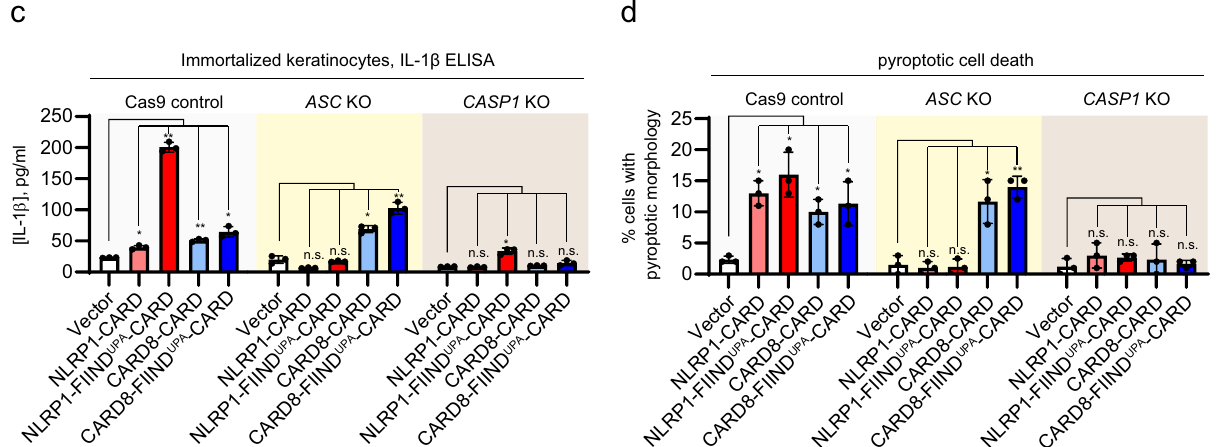
Fig. 6 NLRP1 and CARD8 in fl ammasome assembly in mammalian cells. a Structured illumination microscopy images of NLRP1-CARD-mCherry and CARD8-CARD-mCherry fi laments (red) with ASC-CARD-GFP and CASP1-CARD-GFP fi laments (green). White boxes indicate regions magni fi ed in right panels. b Percentage of ASC-GFP specks or CASP1-CARD-GFP fi laments induced by full-length NLRP1 or CARD8 upon Talabostat treatment (3 μ M). Data are presented as mean values ± SD. P value was calculated with one-way ANOVA, n = 3 treatments. ‘ */**/**** ’ indicates P value <0.05, 0.01, and 0.0001, correspondingly. c IL-1 β secretion in control, ASC KO, and CASP1 KO keratinocytes transfected with the indicated NLRP1 and CARD8 constructs. Data are presented as mean values ± SD. P value was calculated with one-way ANOVA, n = 3 transfections. ‘ */**/**** ’ indicates P value <0.05, 0.01, and 0.0001, correspondingly. d The percentage of cells with pyroptotic morphology in control, ASC KO, and CASP1 KO keratinocytes transfected with the indicated NLRP1 and CARD8 constructs. Data are presented as mean values ± SD. P value was calculated with one-way ANOVA, n = 3 transfections (same as 5c). ‘ */**/**** ’ indicates P value < 0.05, 0.01, and 0.0001,